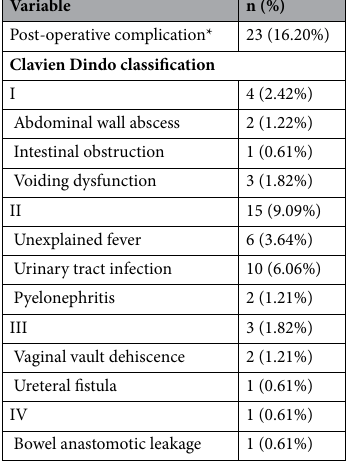
Table 3. Complications. *Some patients had more than one complication.